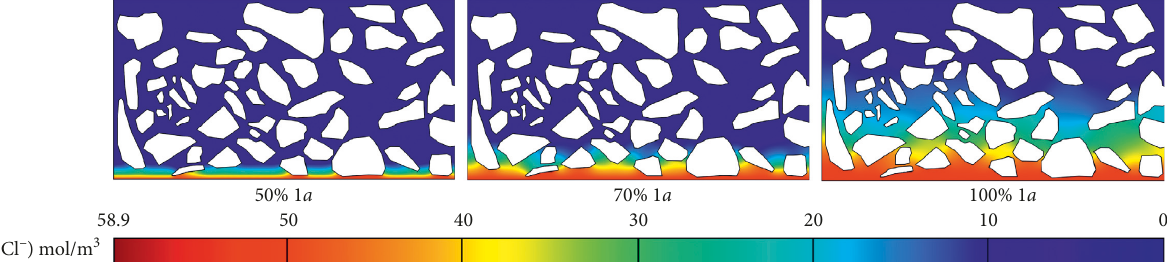
Figure 8: Concentration distribution profiles of the chloride ions under the effect of relative humidity in concrete at 1